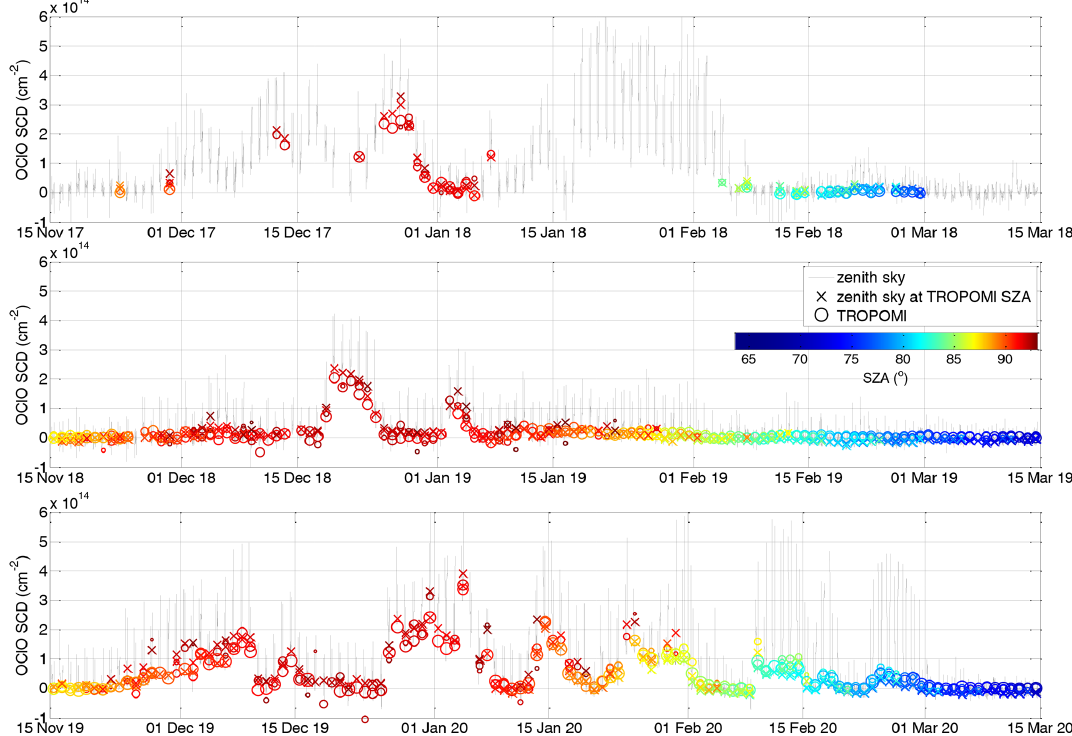
Figure 4. OClO SCDs measured at Kiruna (67.84 ◦ N, 20.41 ◦ E) by the zenith sky DOAS instrument (black line). Their diurnal variation reflects their dependency in particular on SZA. The zenith sky measurements at the TROPOMI SZAs are marked by “ × ”. Collocated TROPOMI measurements are indicated by “o”. The SZAs of these measurements are colour-coded, while the radius of the circles indicates with the number of TROPOMI pixels within the selected area (in range of 100 to ∼